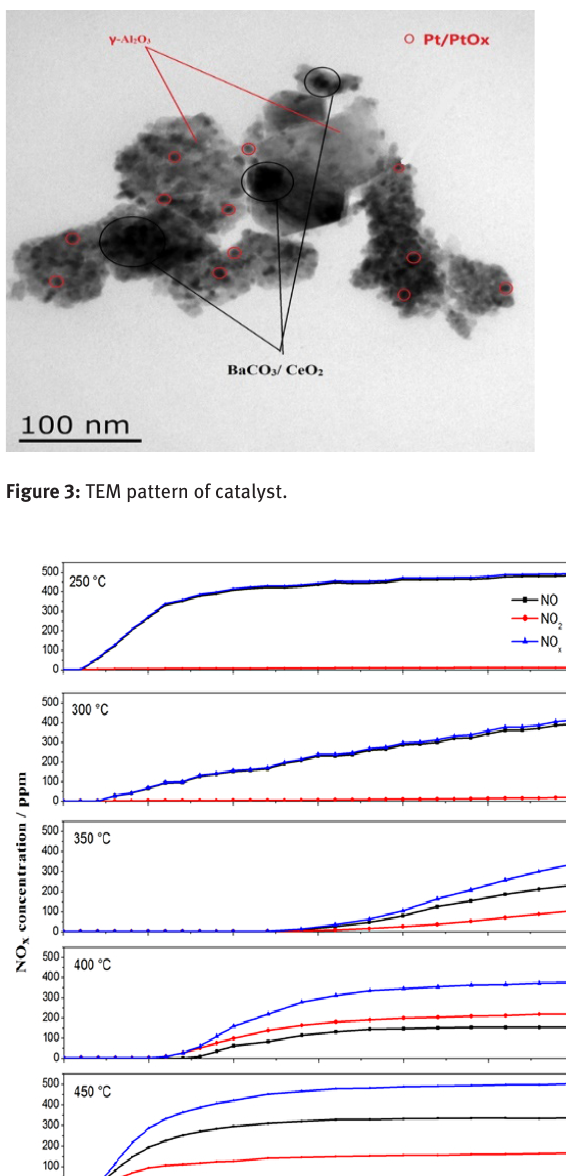
storage efficiency, penetration X